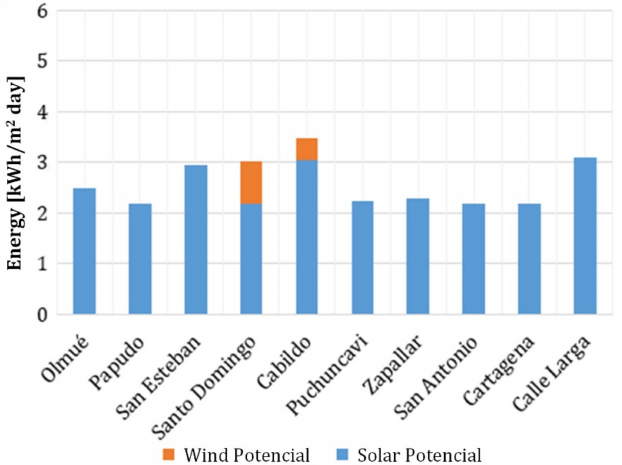
Figure 3. Average daily energy potential as a function of the monthly energy potential of the most critical month (i.e., June), for 1 m 2 of surface area and per